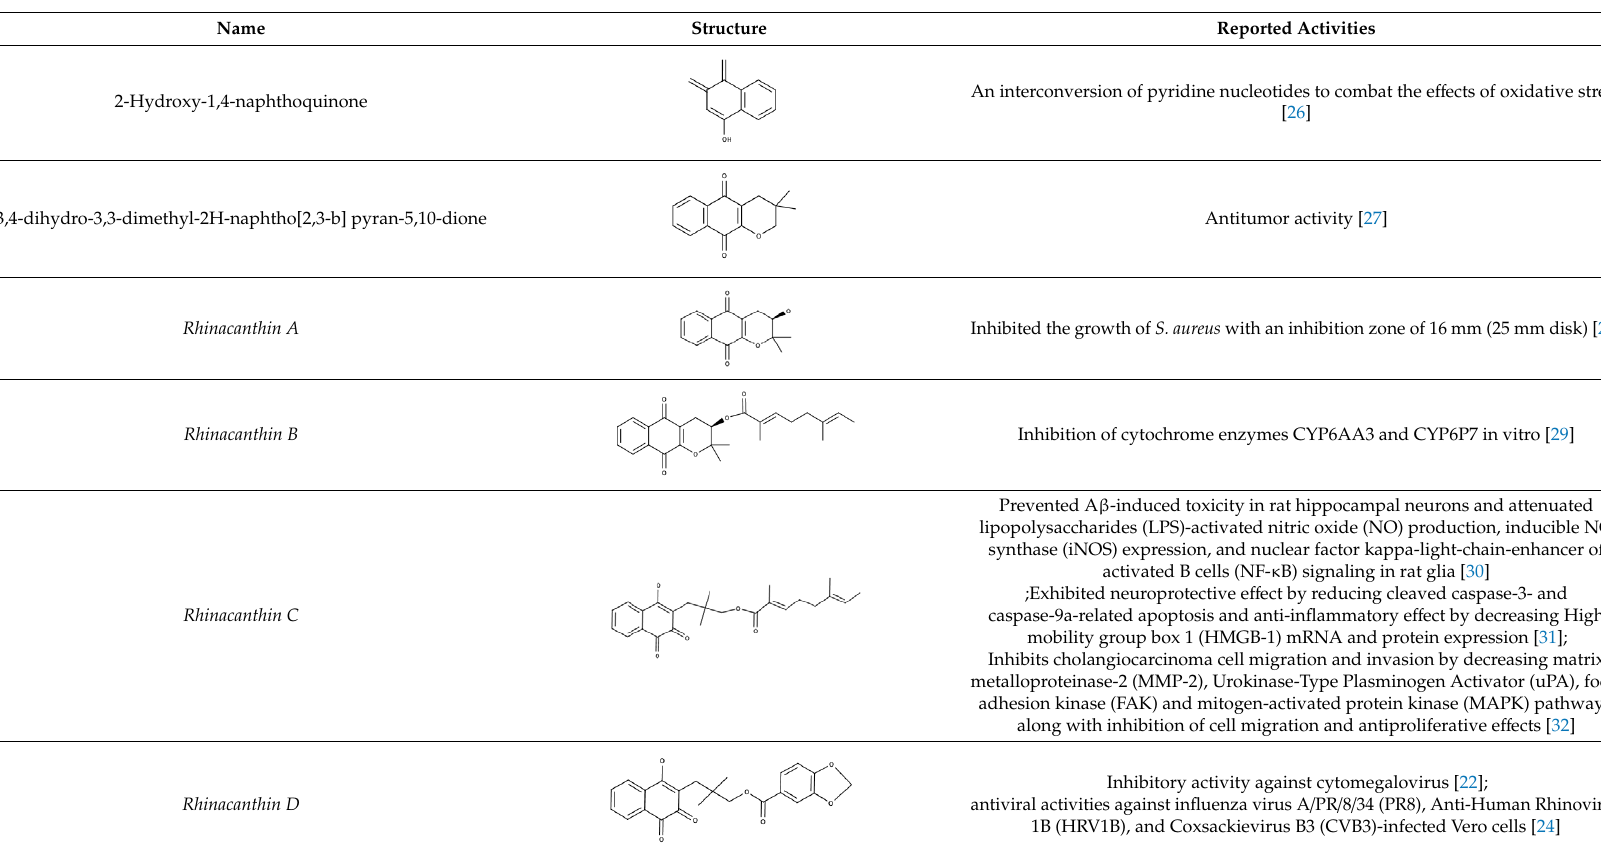
Table 2. Structures and activities of compounds found specifically in Rhinacanthus nasutus extracts.